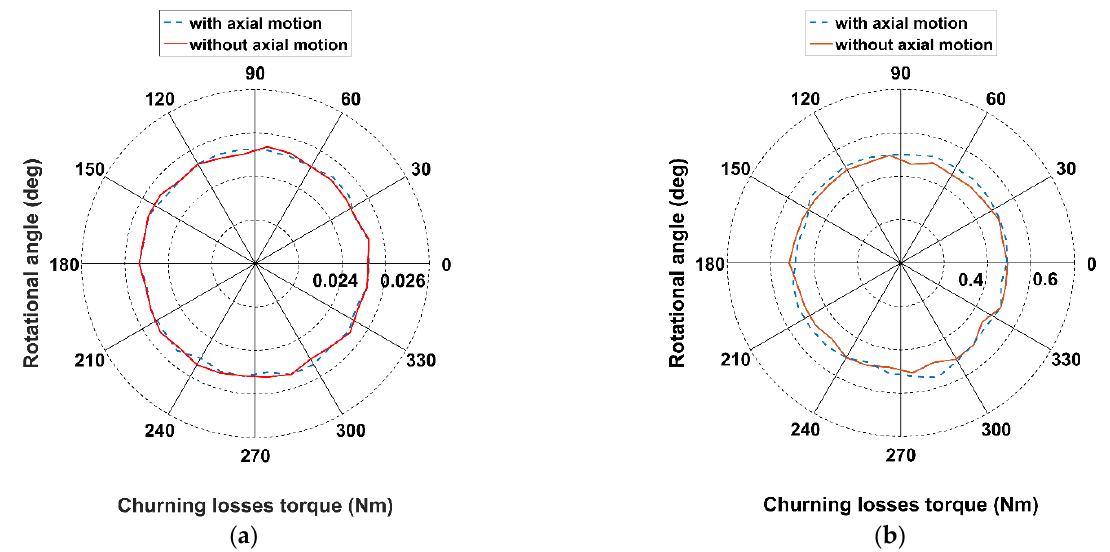
Figure 10. Influence of the axial motion on the churning loss torque at ( a ) 1000 rpm and ( b ) 8000 rpm.